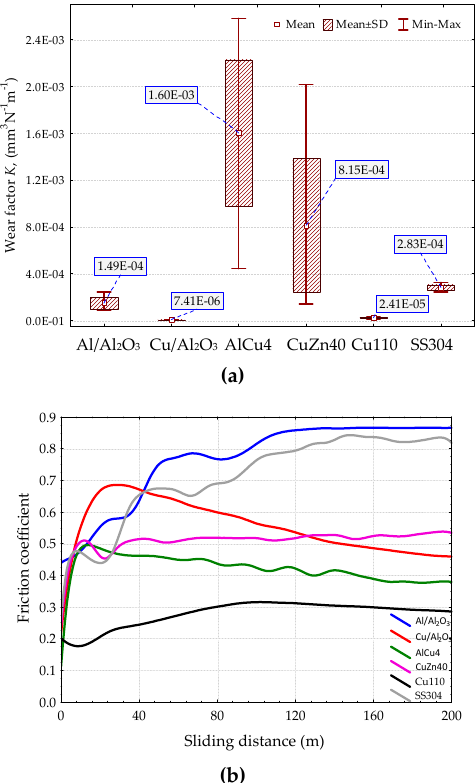
Figure 11. Sliding wear results: ( a ) Wear factor, K ; ( b ) a friction coefficient curves. Table 4. The friction coefficient of tested samples.